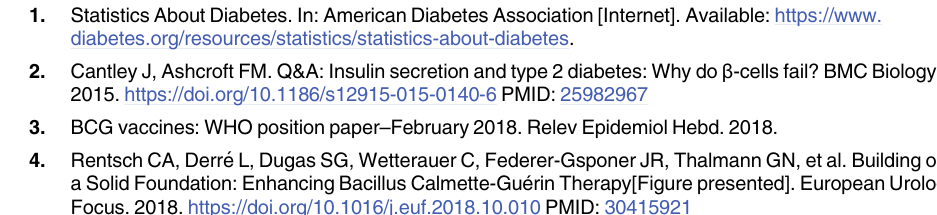
S1 Fig. Flowcharts of the selection criteria of patients. Flowcharts showing the selection cri- teria set for each database to filter for either T1D or T2D